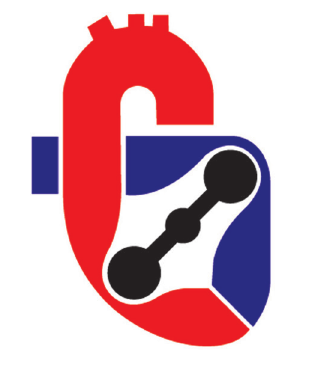
Fig. 4 – App RBCCV / BJCVS symbol for Smartphones and